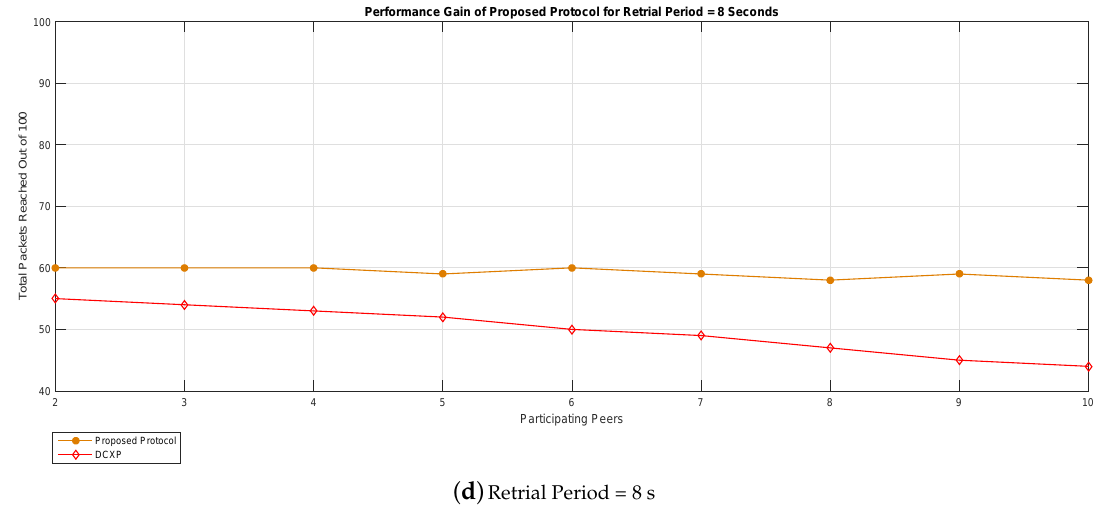
Figure 9. Effect of Peers on Proposed Protocol and DCXP.